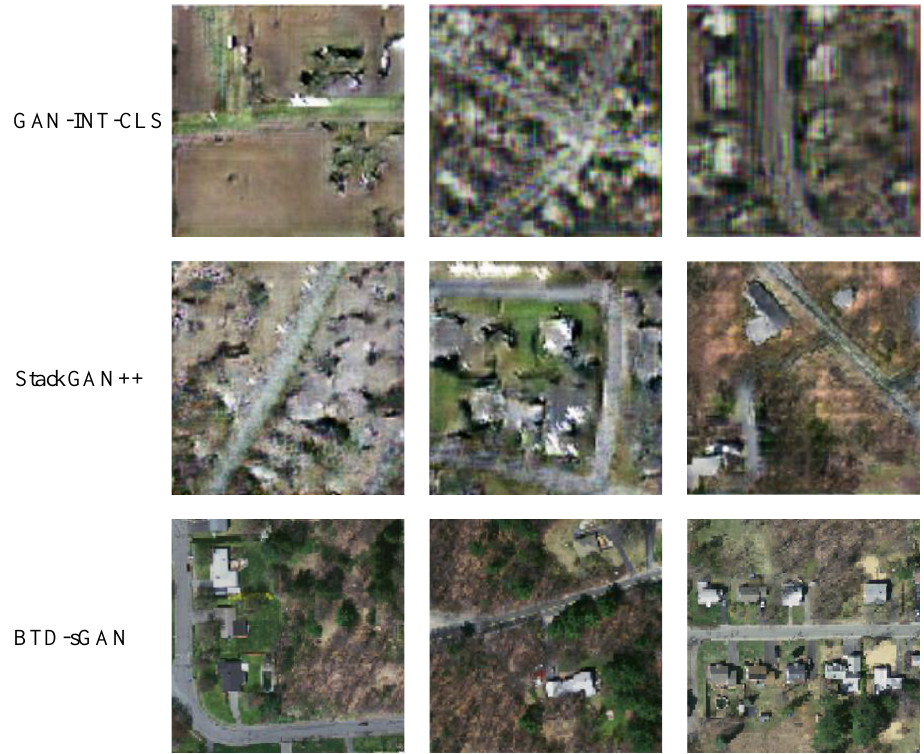
Figure 13. The results of different models on actual remote sensing dataset.